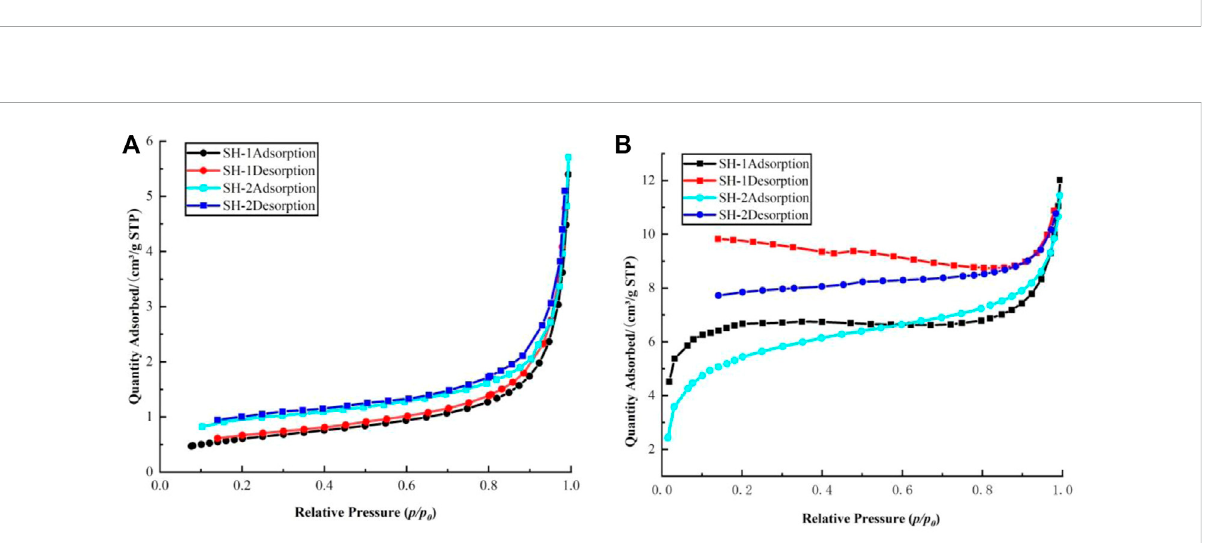
FIGURE 5 Adsorption – desorption curve of the coal samples (A , B)